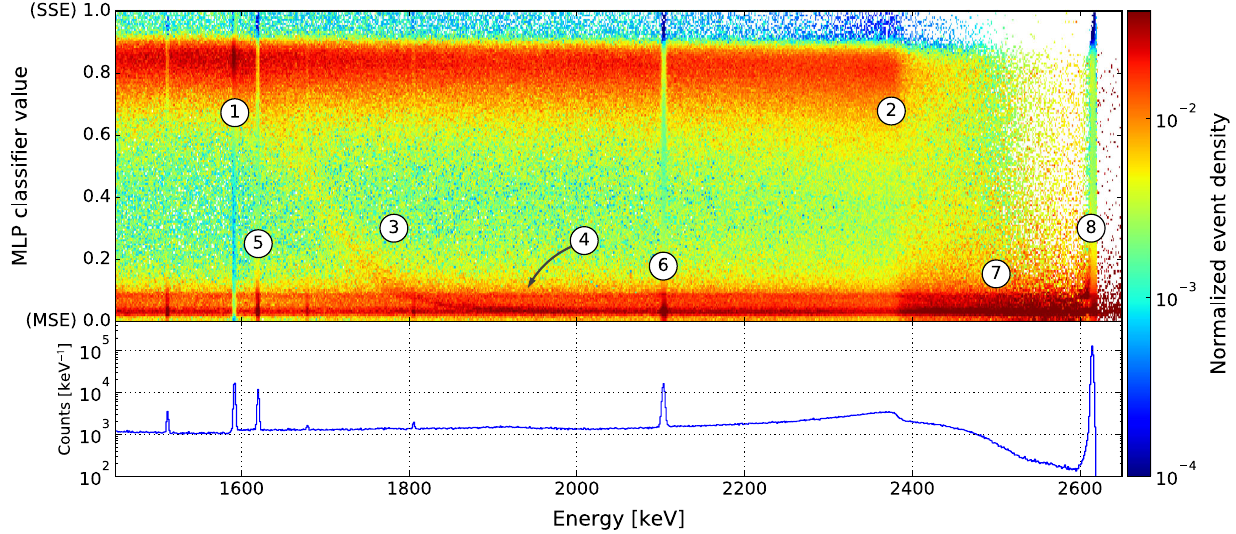
Fig. 6 2D histogram (top panel) showing the distribution of the MLP classifier value (vertical axis) vs. energy (horizontal axis) for the data from 228 Th decay chain. The MLP neural network was trained using DEP and FEP training data (see text for details). The energy spectrum corresponding to the upper histogram is shown in the bottom panel. The 2D histogram shows clearly separated bands corresponding to SSEs